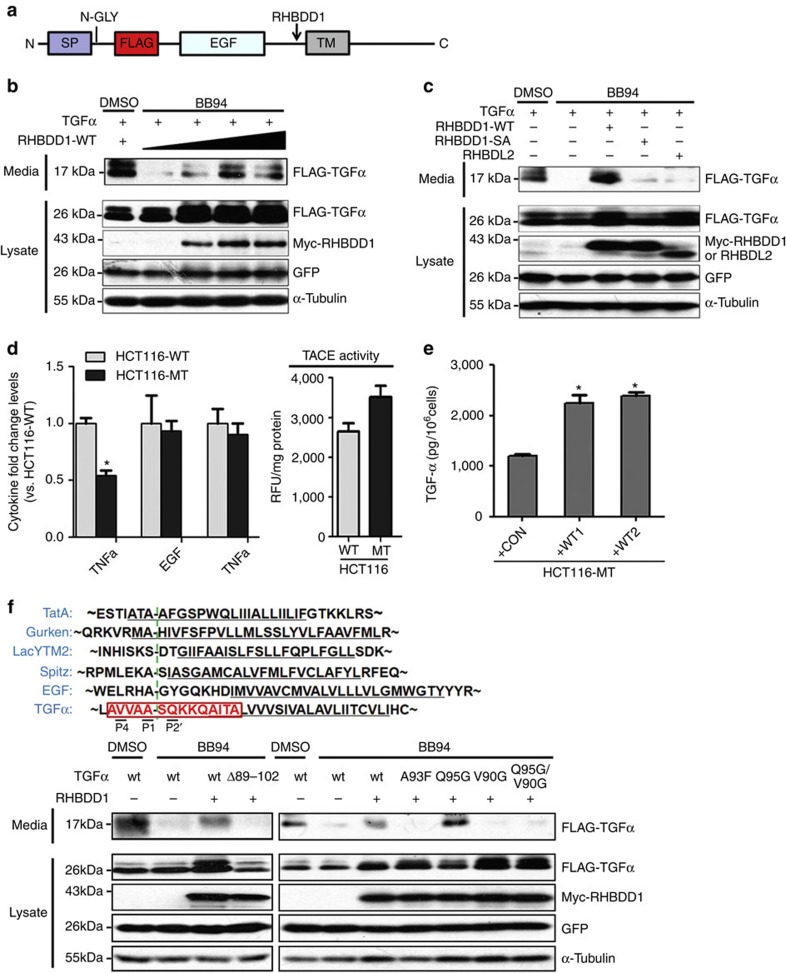
RHBDD1 induces the specific cleavage and ADAM-independent secretion of proTGFα.(a) Schematic of the proTGFα domain structure and the position of the FLAG tag. The RHBDD1-induced cleavage site and the N-glycosylation site were indicated. (b) RHBDD1 induces the ADAM-independent secretion of TGFα in a dose-dependent manner. HEK 293T cells were transfected with proTGFα-FLAG (1 μg) and RHBDD1-Myc (0, 250, 500 or 750 ng) constructs. The secretion assay was performed in serum-free medium containing 10 μM BB94. The proteins in culture supernatants were precipitated by TCA, recovered, solubilized in loading bufferand analysed by western blotting.GFP and α-tubulin were used as the transfection and loading controls, respectively. (c) RHBDD1 induces the ADAM-independent secretion of TGFα in an enzymatic activity-dependent manner. HEK 293T cells were transfected with proTGFα-FLAG (1 μg) and RHBDD1-WT, RHBDD1-SA or RHBDL2 (500 ng) constructs. The experiment was then performed as described in (b). (d) RHBDD1 specifically induces endogenous TGFα secretion. Media from wild-type or mutant HCT116 cells were collected and assayed for soluble TGFα, EGF and TNFα levels by ELISA, and the relative fold changes were plotted. The data are presented as means±s.d., N=3, the Student's two-tailed t-test, *P<0.05. (e) Media from mutant HCT116 cells in which RHBDD1 recombinant protein was re-introduced were collected, and soluble TGFα level was measured by ELISA. The data are presented as picograms per 106 cells±s.d. of three independent experiments. The data are presented as means±s.d., N=3, the Student's two-tailed t-test, *P<0.05. (f) RHBDD1 cleaves proTGFα within the juxtamembrane region at Ala 93. An alignment of the rhomboid recognition motifs in TatA, Gurken, Lac YTM2, spitz and EGF with the corresponding residues of proTGFα. The cleavage region is highlighted and boxed in red, and the cleavage site is indicated in a green dotted line. HEK 293T cells were transfected with Myc-tagged RHBDD1 (500 ng) and FLAG-tagged proTGFα, proTGFα deletion (Δ89–102) or proTGFα mutation (A93F, Q95G, V90G, Q95G/ V90G and 1 μg) constructs, respectively. GFP and α-tubulin were used as the transfection and loading controls, respectively.